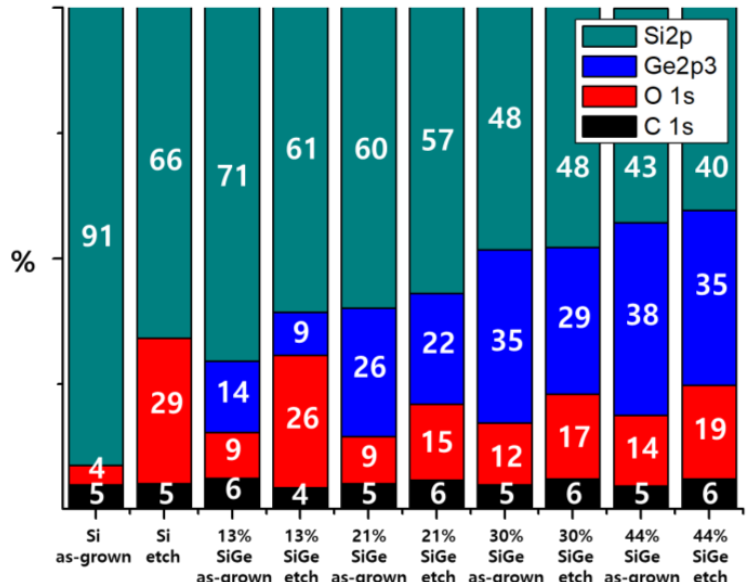
Figure 7. X-ray photoelectron spectroscopy (XPS) surface composition of Si and Si 1 − x Ge x (x = 0.13, 0.21, 0.30, and 0.44) after HF cleaning and TMAH etching.